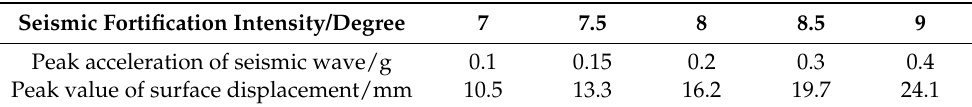
Table 5. Peak vertical displacements of the soil mass. Seismic Fortification